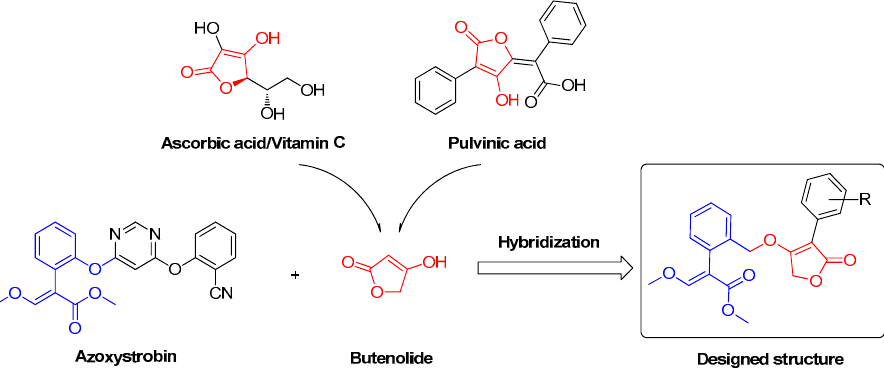
Figure 1. Design strategy of natural butenolides-acrylate conjugates.